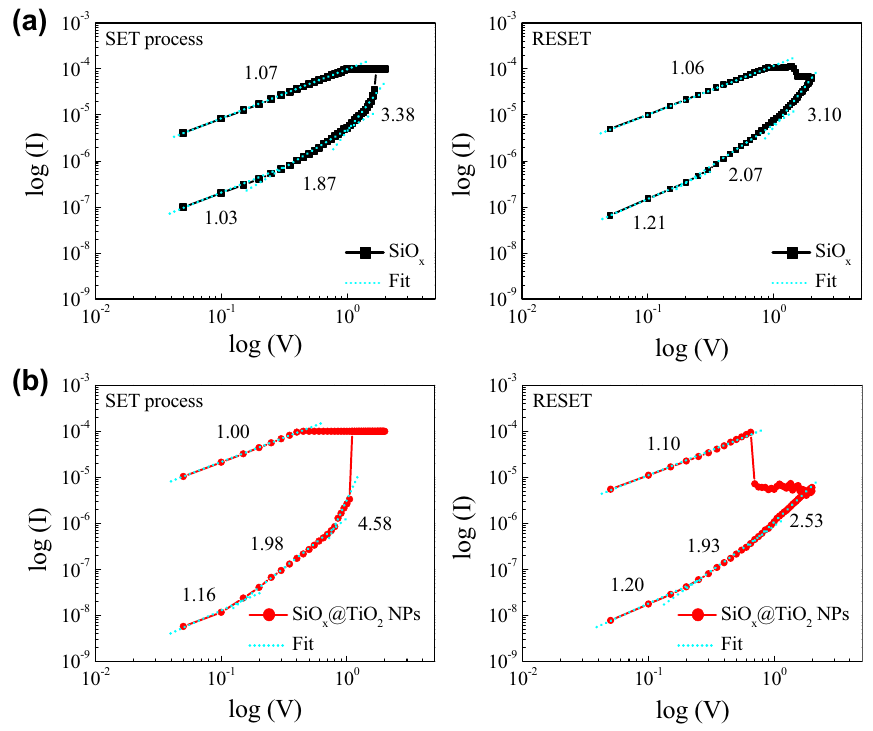
Figure 4. Log I–log V plot of the I–V curves of the ( a ) SiO x , and ( b ) SiO x @TiO 2 NPs in the SET and RESET